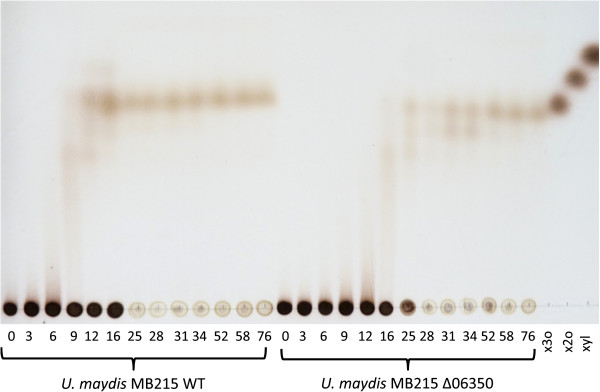
Analysis of the xylan hydrolysis products in the supernatant of a U. maydis MB215 and a U. maydis MB215 Δ06350 culture grown on xylan at different time points (in h) by TLC, x3o: 5 g l-1xylotriose; x2o: 5 g l-1xylobiose; xyl: 5 g l-1xylose solution.